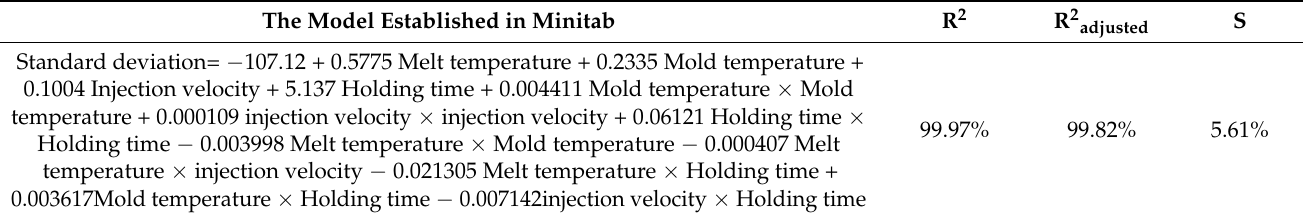
Table 5. Regression model between process parameters and replication